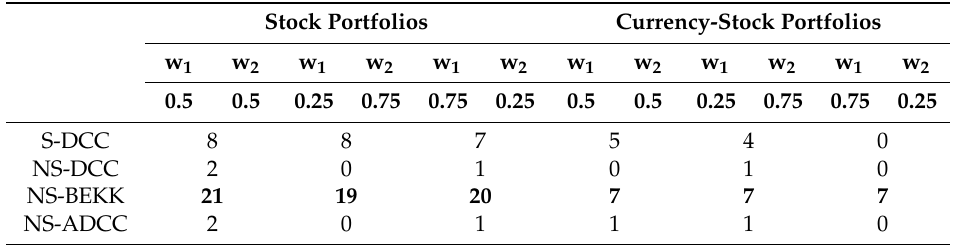
Table 12. The summary results of the efficiency evaluation test based on the market risk capital (MRC) for the three weight combinations of the stock and currency-stock